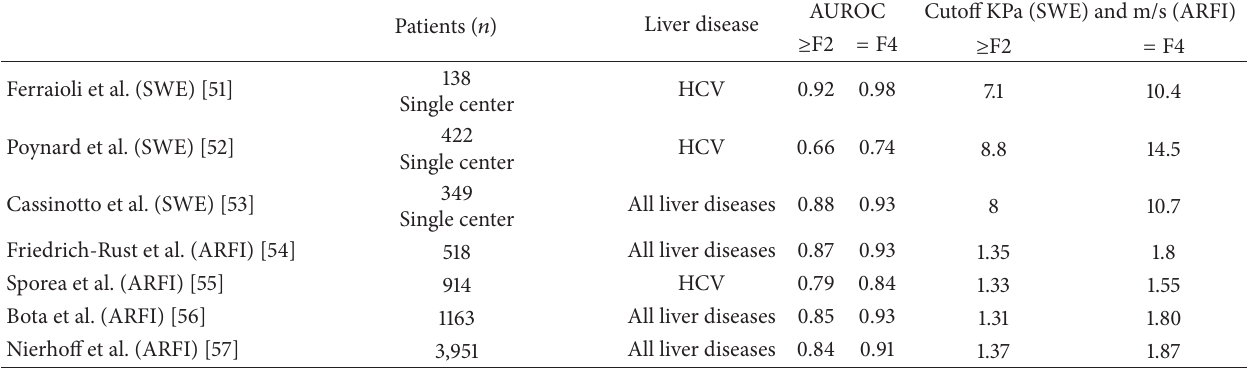
Table 3: Diagnostic use of acoustic impulse based techniques of elastography in